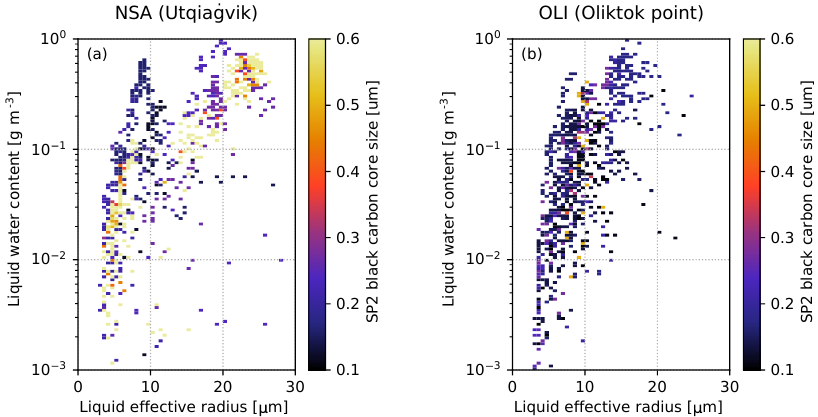
Figure 9. As Fig. 8, but with the mean size of refractory black carbon rBC measured below